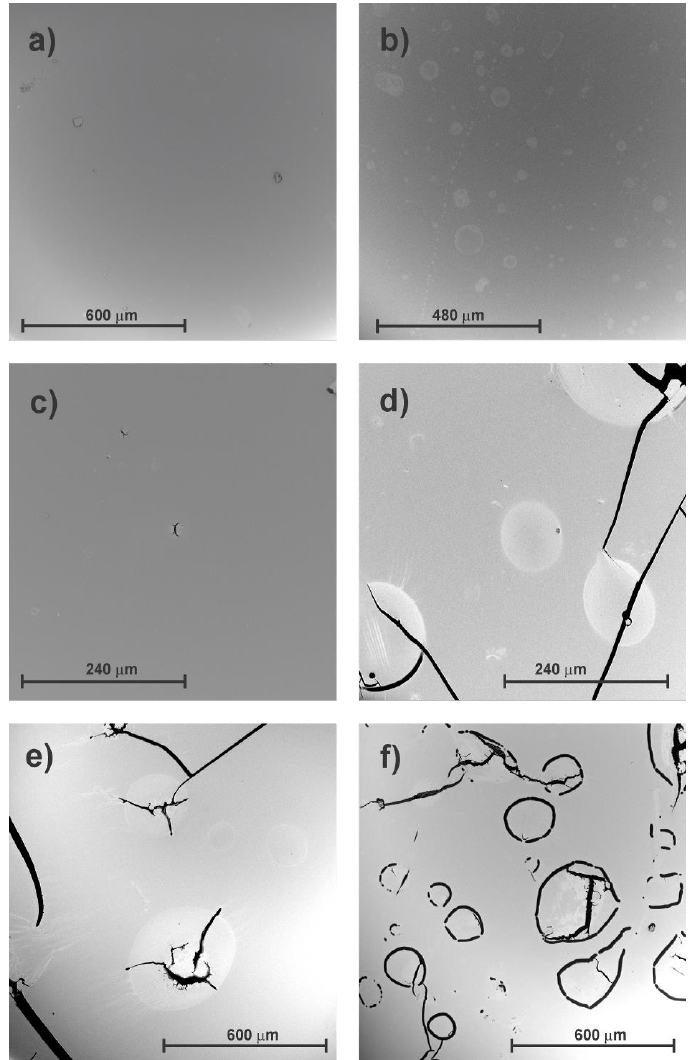
Figure 3. Scanning electron microscopy (SEM) micrograph of surface of SEBS: ( a ) without exposure (T0) (200×), ( b ) UV exposure T1 (250×), ( c ) UV exposure T3 (500×), ( d ) UV exposure T5 (500×), ( e ) UV exposure T7 (200×), and ( f ) UV exposure T9 (200×).